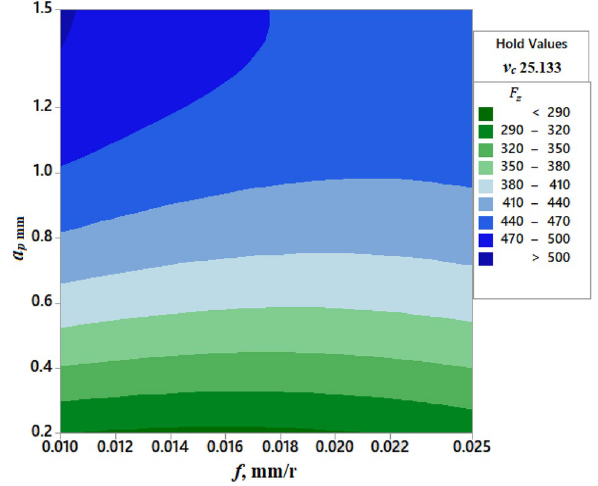
Fig. 15 Cutting force F z vs a